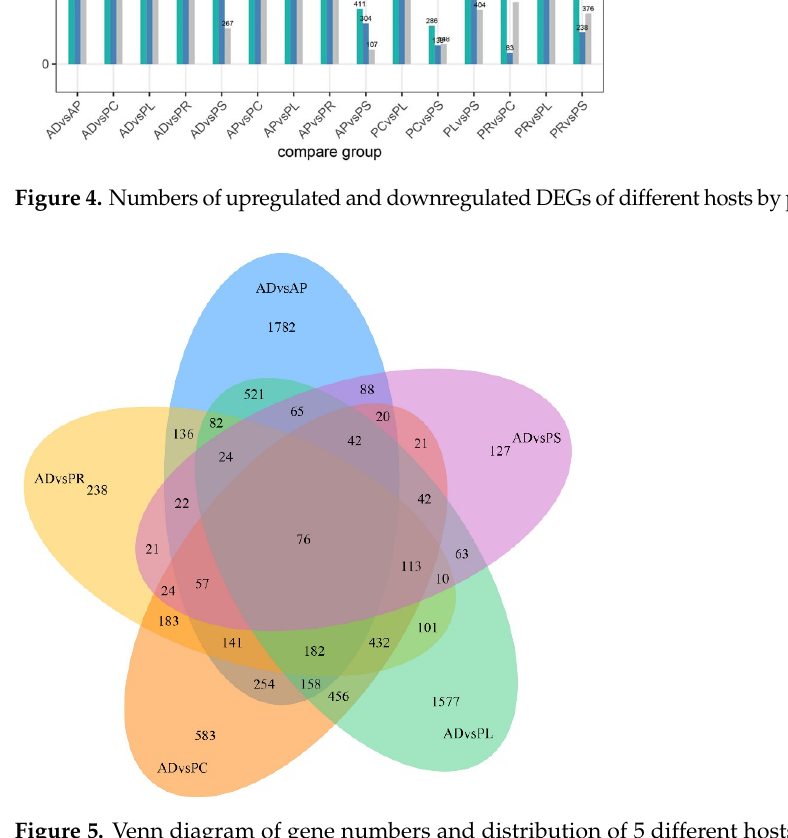
Figure 5. Venn diagram of gene numbers and distribution of 5 different hosts pairwise compared with